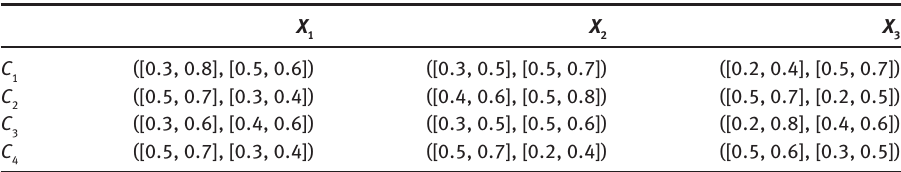
Table 4: Normalized Pythagorean Fuzzy Decision Matrix R 1 .